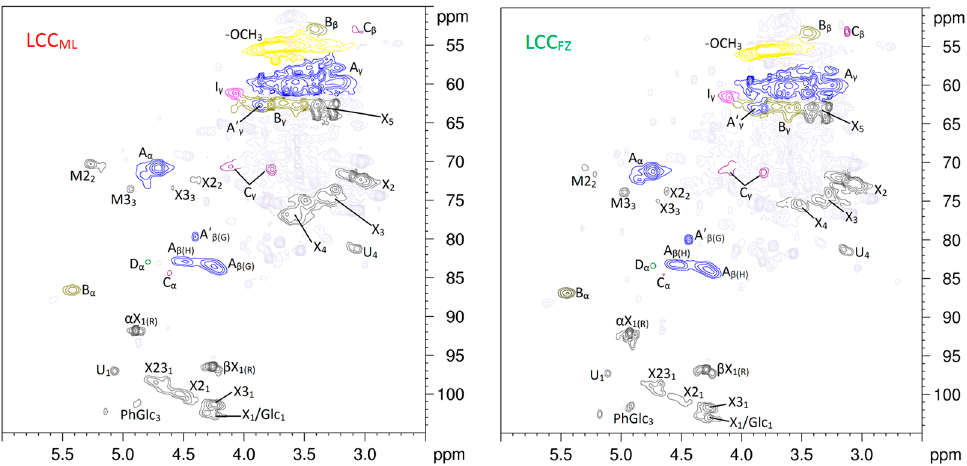
Figure 5. Carbohydrate anomeric regions ( δ C / δ H 105–50/6.0–2.5) of LCC ML and LCC FZ in the 2D HSQC NMR spectra. M and X are β - D -mannopyranoside and β - D -xylopyranoside units, correspondingly. M 2 and M 3 are β - D -mannopyranoside units O -acetylated at C 2 and C 3 positions, correspondingly. X2, X3, and X23 are β - D -xylopyranoside units O -acetylated at C 2 , C 3 , and both positions, correspondingly. α X and β X are α - and β -reducing end carbohydrate units, correspondingly. Table 3. Assignment of the polysaccharide signals in the 2D HSQC NMR spectra of LCCs.